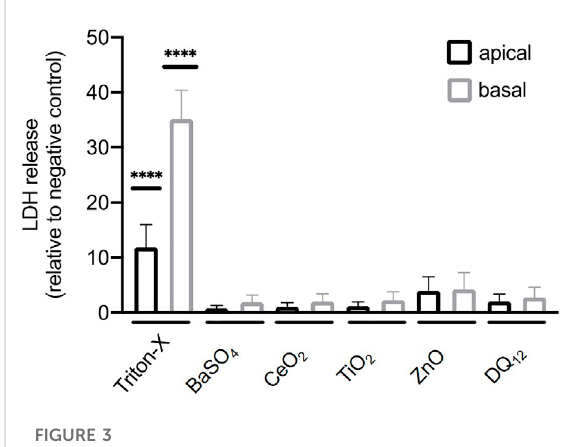
FIGURE 3 Cytotoxicity determined by measuring the release of lactate dehydrogenase (LDH) by A549 cells after the exposure of 100 µg/ ml BaSO 4 NMs, CeO 2 NMs, TiO 2 NMs, ZnONMs, and DQ 12 for 80 h. A total of three independent experiments ( n = 3), consisting of three single replicates each, were performed. Statistically signi fi cant difference to the negative control is denoted by asterisks, where **** is p <